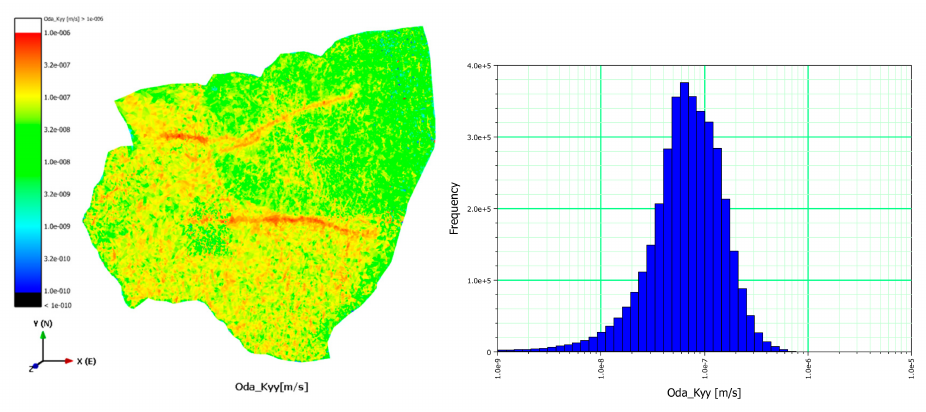
Figure 12. Upscaled hydraulic conductivity tensor in y-direction, K yy